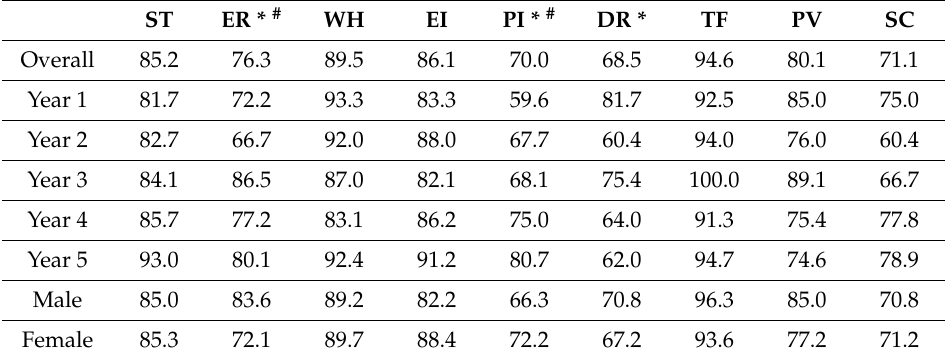
Table 3. Average positive response rate (APRR) the nine domains in APSQ.